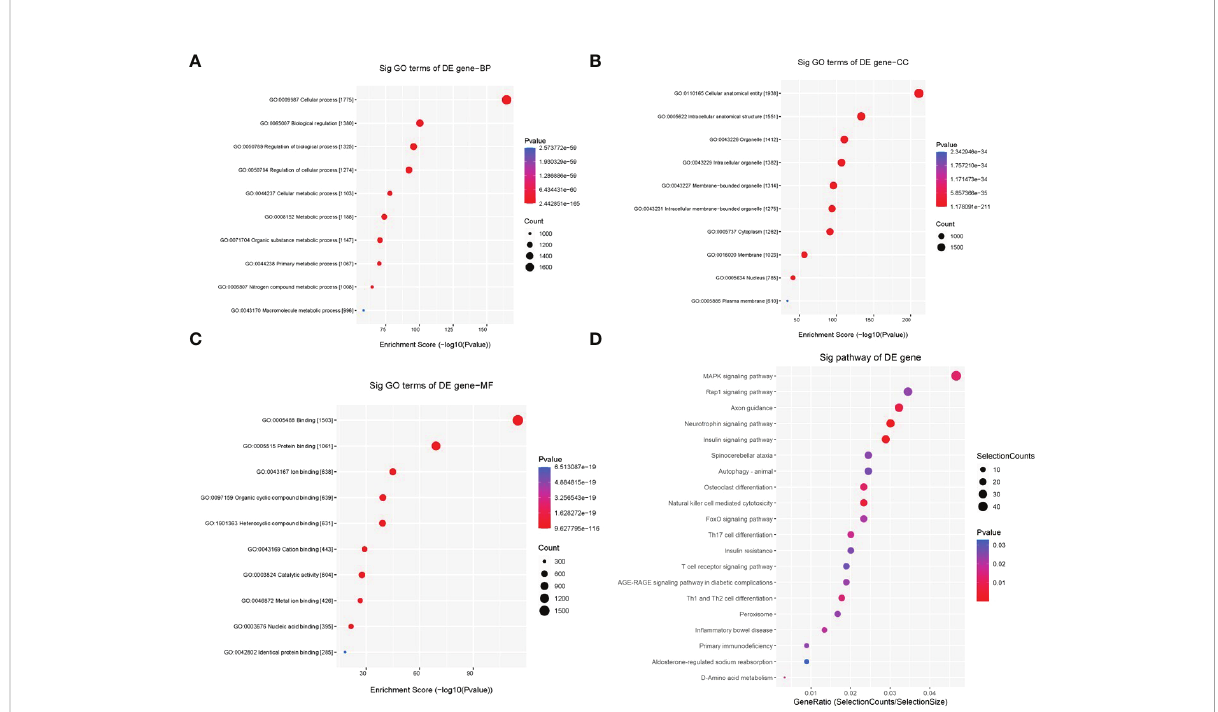
FIGURE 3 GO and KEGG pathway enrichment analyses of 4 upregulated tRFs in HG-treated primary cardiomyocytes. (A) BP terms mainly included cellular process, regulation of biological process, regulation of cellular process, cellular metabolic process and macromolecule metabolic process. (B) CC terms mainly included intracellular organelle, intracellular membrane-bounded organelle, cytoplasm, membrane-bounded organelle, membrane, nucleus and plasma membrane. (C) MF terms mainly included binding, protein binding, catalytic activity, nucleic acid binding and identical protein binding. (D) KEGG pathway enrichment analysis demonstrated the involvement of the following pathways: autophagy, AGE- RAGE signaling pathway in diabetic complications, MAPK signaling pathway, insulin signaling pathway, FoxO signaling pathway, insulin resistance and peroxisome